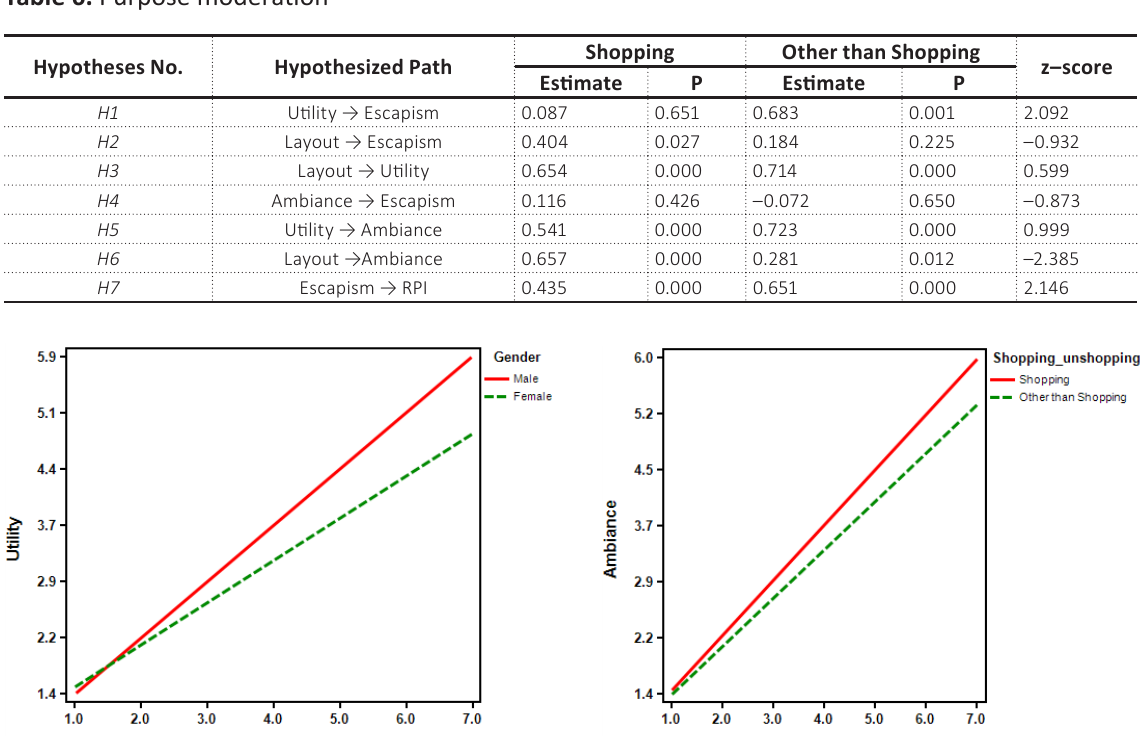
Table 6. Purpose moderation